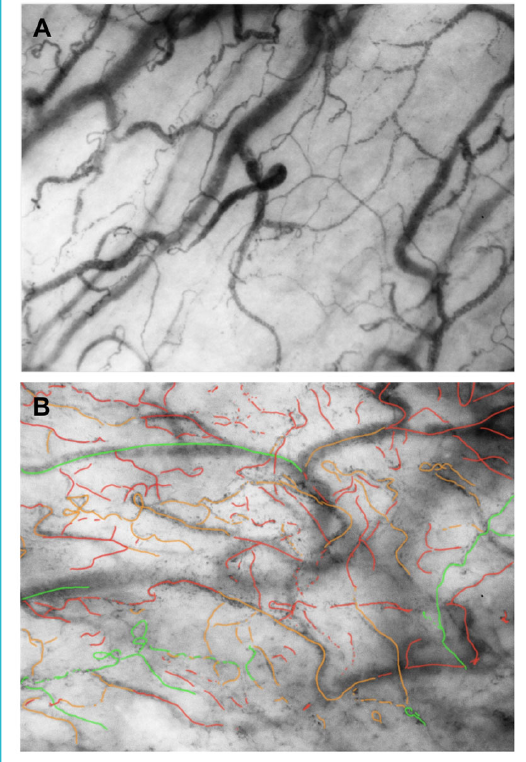
Figure 1: Changes of the microcirculation under the tongue of a patient in shock with incident dark field (IDF) imaging (CytoCam- IDF, Braedius Medical, Huizen, The Netherlands). Panel A shows the normal microcirculation with normal flow in capillaries and venules. Panel B illustrates the different microcirculatory flow pat- terns during shock. Very few normally perfused (green lines) next to intermittently perfused (orange lines) vessels. Almost half of the vessels show no-flow (red lines), meaning that the blood cells do not move. Fluid resuscitation of shock aims to improve or nor- malise microvascular blood